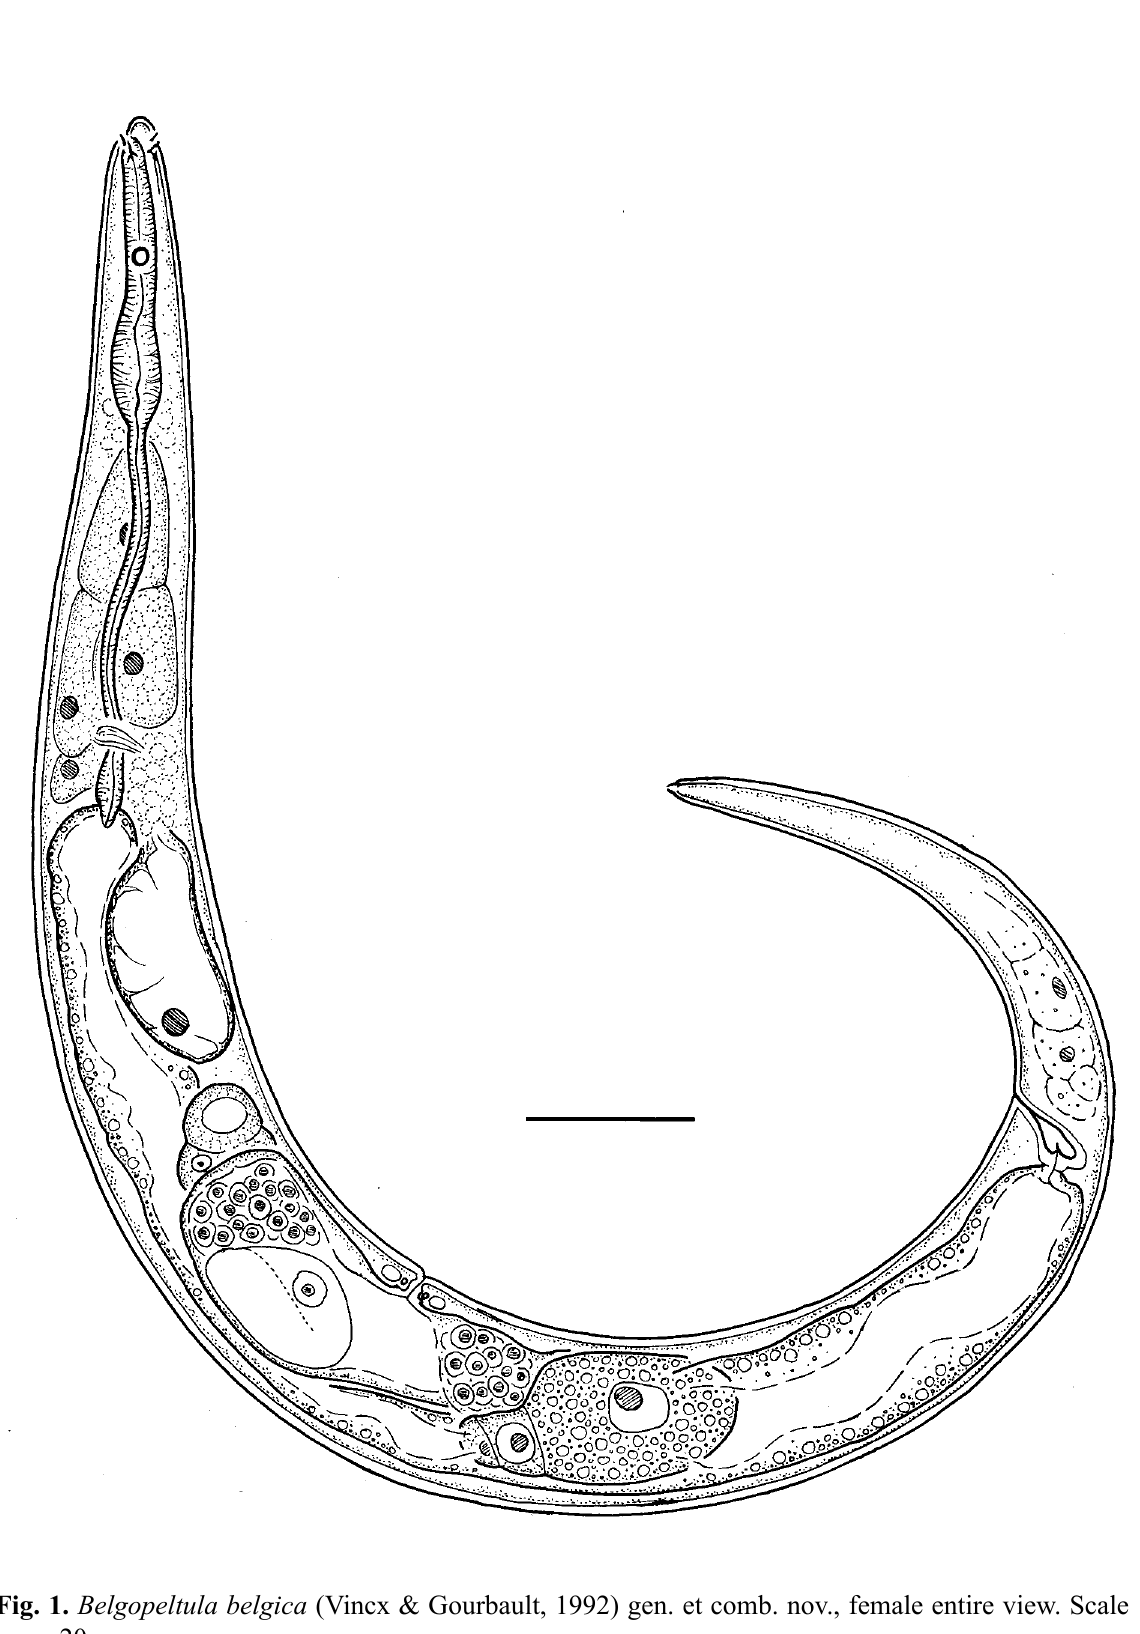
Fig. 1. Belgopeltula belgica (Vincx & Gourbault, 1992) gen. et comb. nov., female entire view. Scale bar = 20